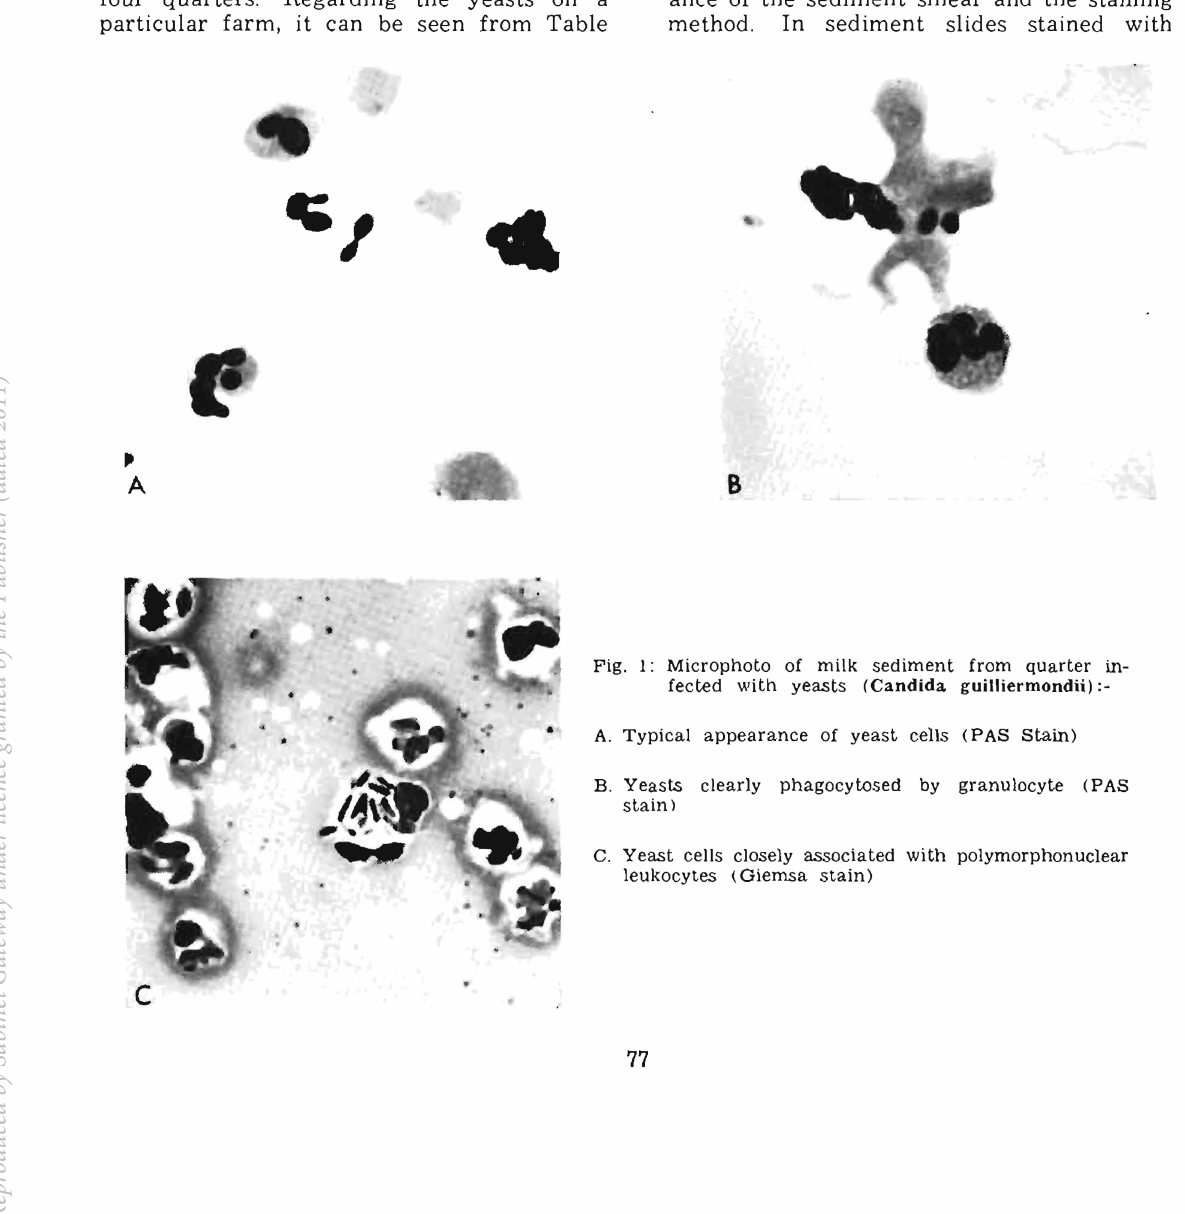
Fig. I: Microphoto of milk sediment from quarter in feeted with yeasts (Candida guilliermondii) :- A. Typical appearance of yeast cells (PAS stain) B. Yeasts clearly phagocytosed by granulocyte (PAS stain) C. Yeast cells closely associated with polymorphonuclear leukocytes (Giemsa